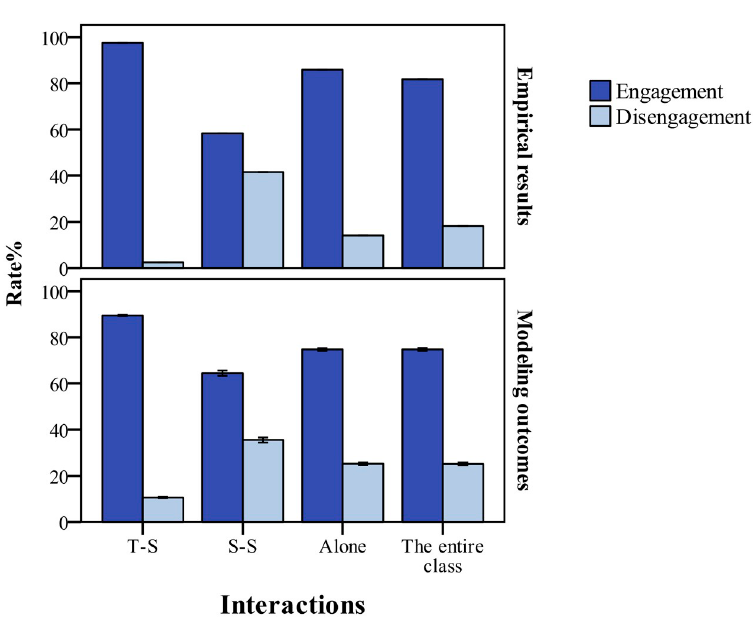
Fig 1. Empirical results vs. modeling outcomes on classroom engagement in student interaction scenarios. The trends of engagement vs. disengagement rates within and between three types of student interactions are similar. “T-S” refers to student interactions with the teacher, “S-S” refers to student interactions with peers, and “Alone” refers to no interactions. Error bars in all simulation figures indicate one standard error (i.e., the sample standard deviation divided by the square root of the number of replications).